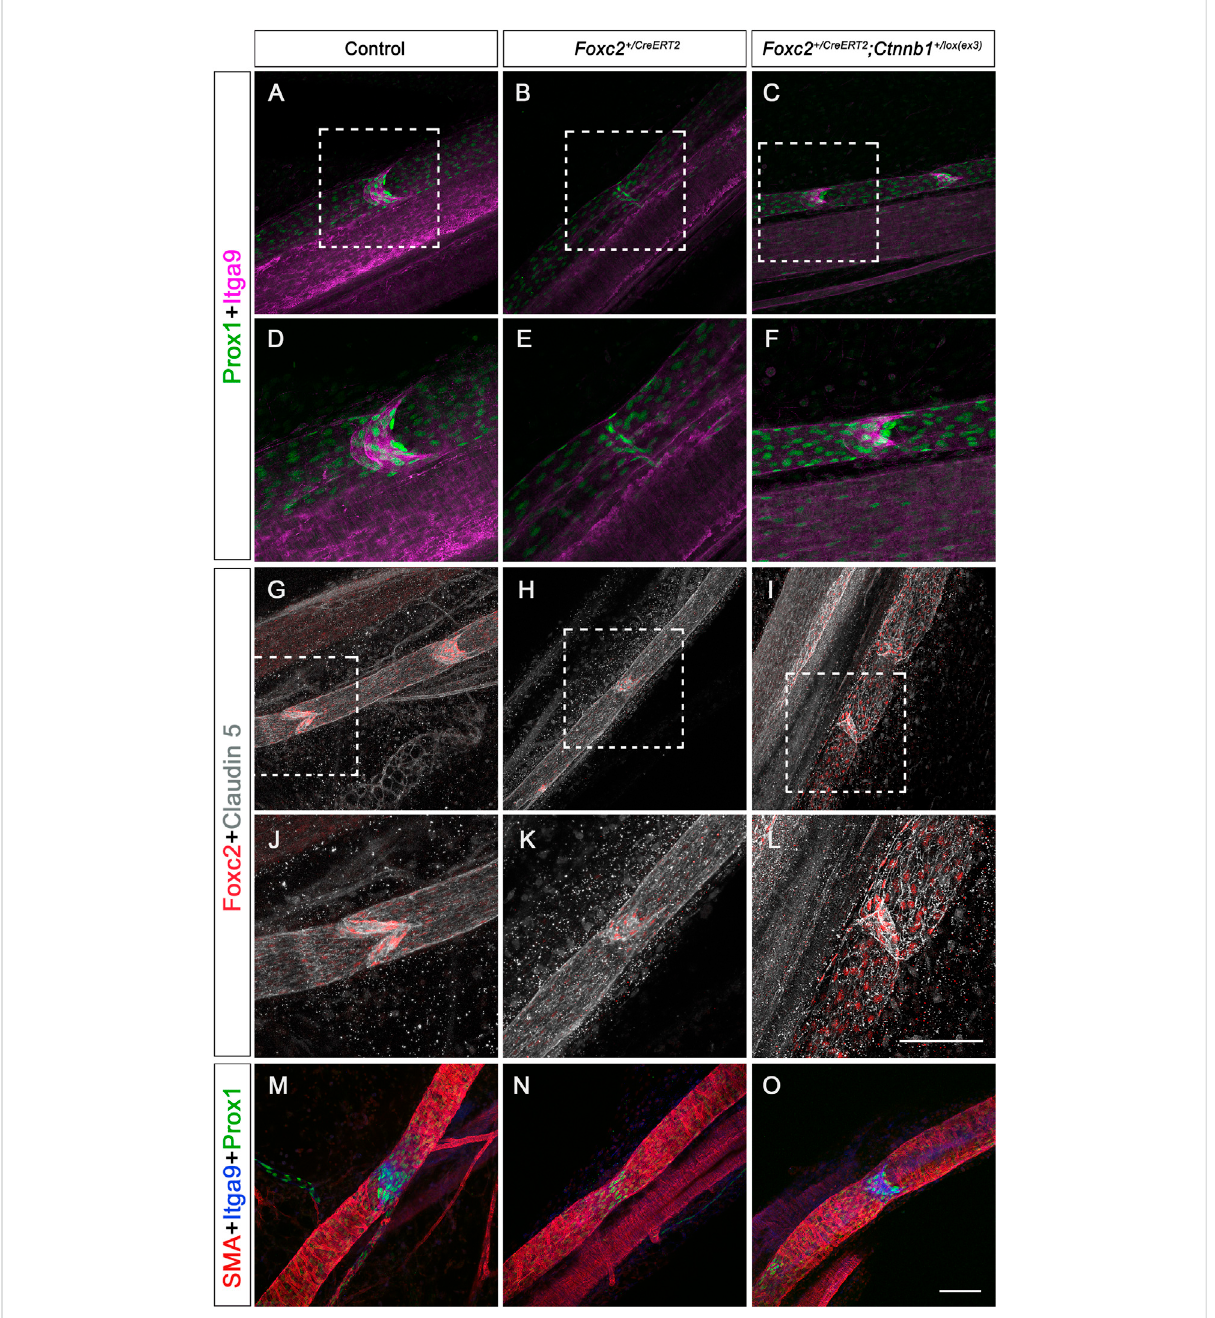
FIGURE 6 Immunostainingofvalvegenes,tightjunctionproteins,andSMAinP8andP14mesentericvesselswithpostnataldeletion. (A – O) Whole-mount immunostainingofmesenterieswithP1 TMinjectionfromcontrol, Foxc2 +/CreERT2 ,and Foxc2 +/CreERT2 ; Ctnnb1 +/lox(ex3) withProx1 (green),Itga9 (purple), Foxc2 (red), and claudin 5 (gray) at P8, SMA (red), Itga9 (blue), and Prox1 (green) at P14. (D – F, J – L) are higher magni fi cation images of (A,B,C,G,H,I) . Scale bars are 100 μ m. Four controls and four knockouts were used in the